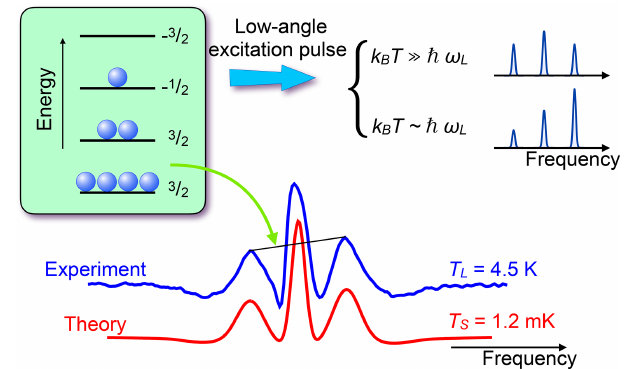
Figure 21. Experimental and simulated NMR spectra of 75 As in GaAs, measured with a small flip angle. The different amplitudes of the quadrupole satellites are then proportional to the population differences across the corresponding transitions and therefore allow a direct measurement of the spin temperature. The calculated popu- lations of the four levels are 0.123, 0.185, 0.277, and